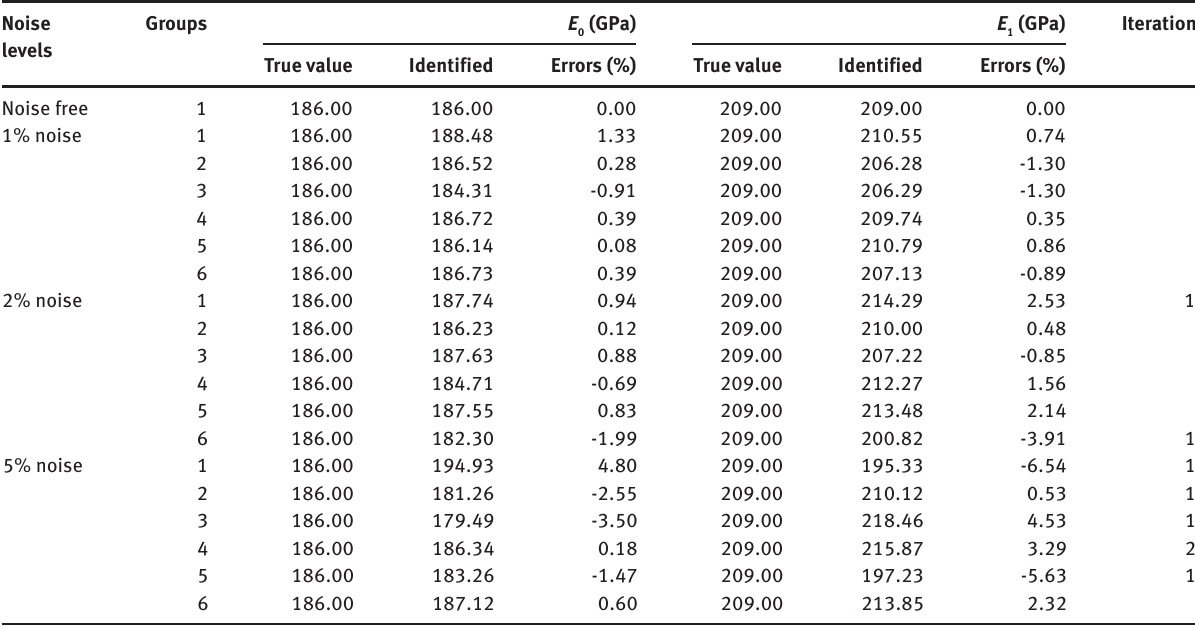
Table 10: Identified parameters of a rectangular FGM plane structure with linear material variation (case 3: initial value E GPa).